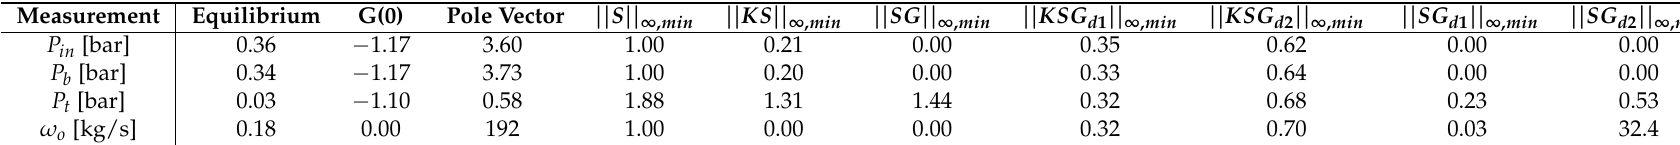
Table 4. Model analysis for Z = 45%.